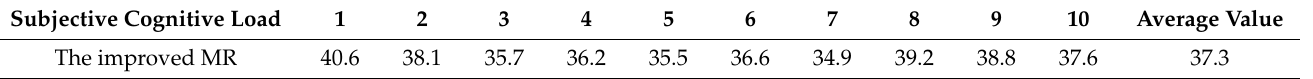
Table 10. Subjective cognitive load of MR display interactive system after multi-channel